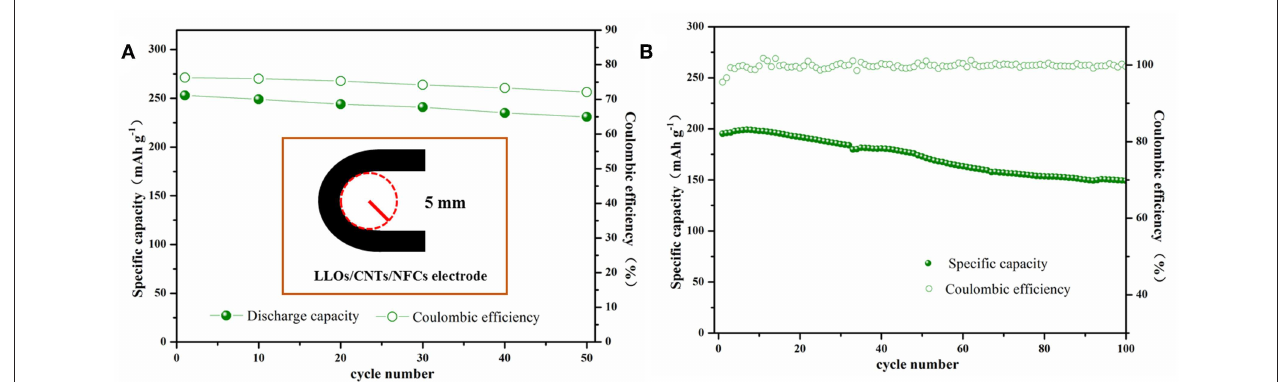
FIGURE 6 | (A) The initial discharge capacities and Coulombic efficiencies of flexible LFP/G/NFC electrode vs. bending times, and the inset represents the schematic of the bending test; (B) Cycle performance and Coulombic efficiencies of the LLOs/CNTs/NFCs electrode after bended repeatedly below a curvature radius of 5mm for 50